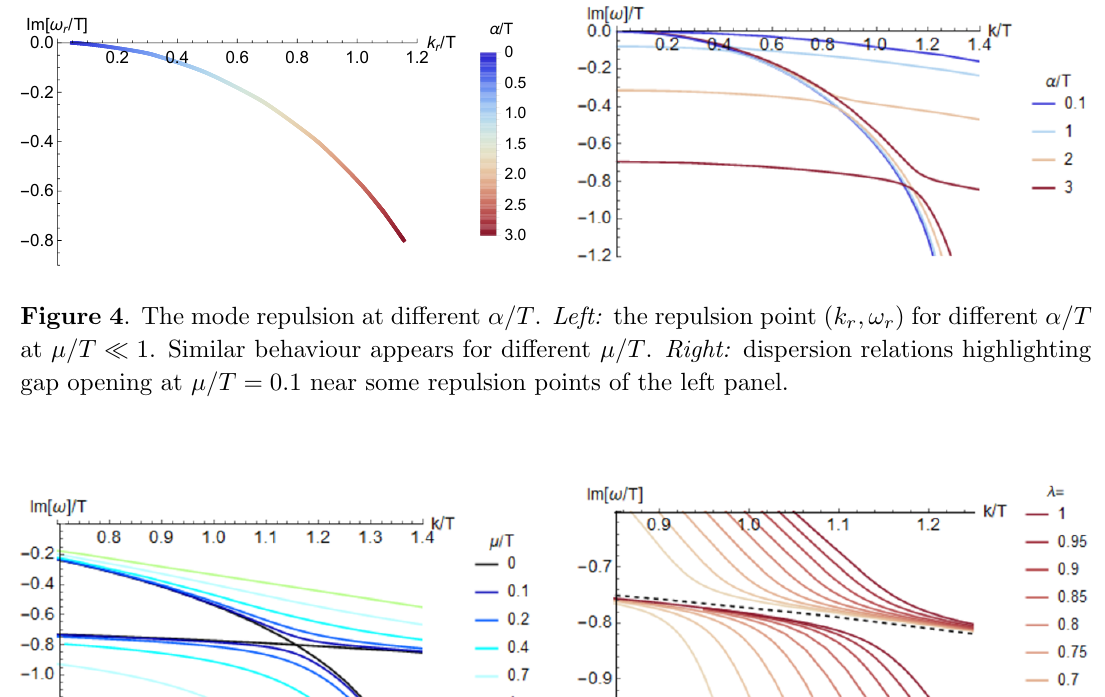
as, to zeroth order, the position of the repulsion point is proportional to the gap (cid:0) of